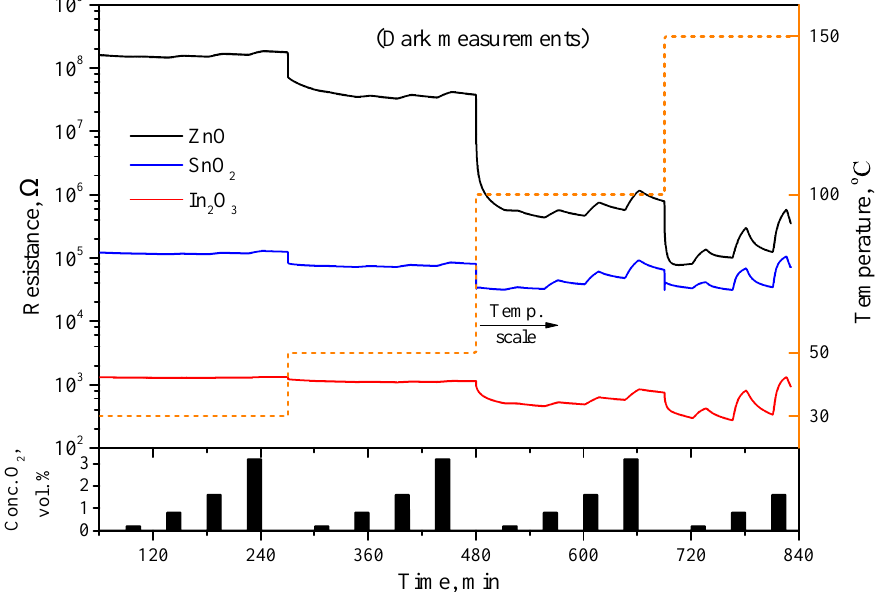
Figure 6. Electrical resistance of ZnO-, SnO 2 -, and In 2 O 3 -based sensors in dark depending on the content of oxygen in gas phase in range of 0.2–3.2 vol.% at temperatures 30, 50, 100, and 150 ◦ C. Nitrogen was used as background